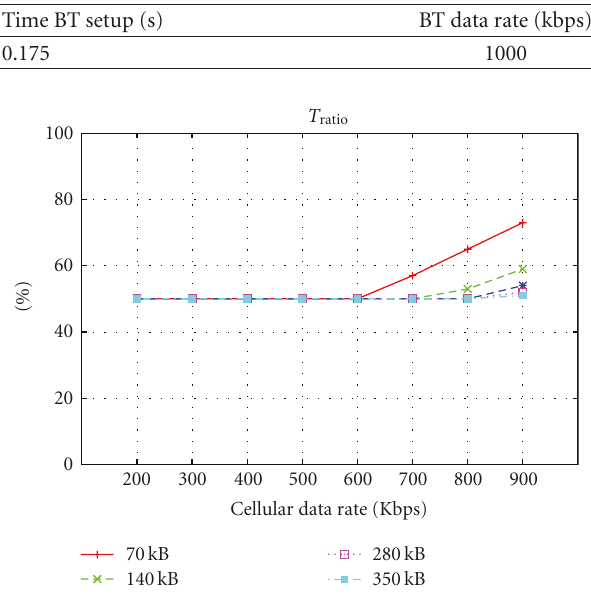
Mean values for T BT setup and DR BT obtained during the tests are shown in Table 1.